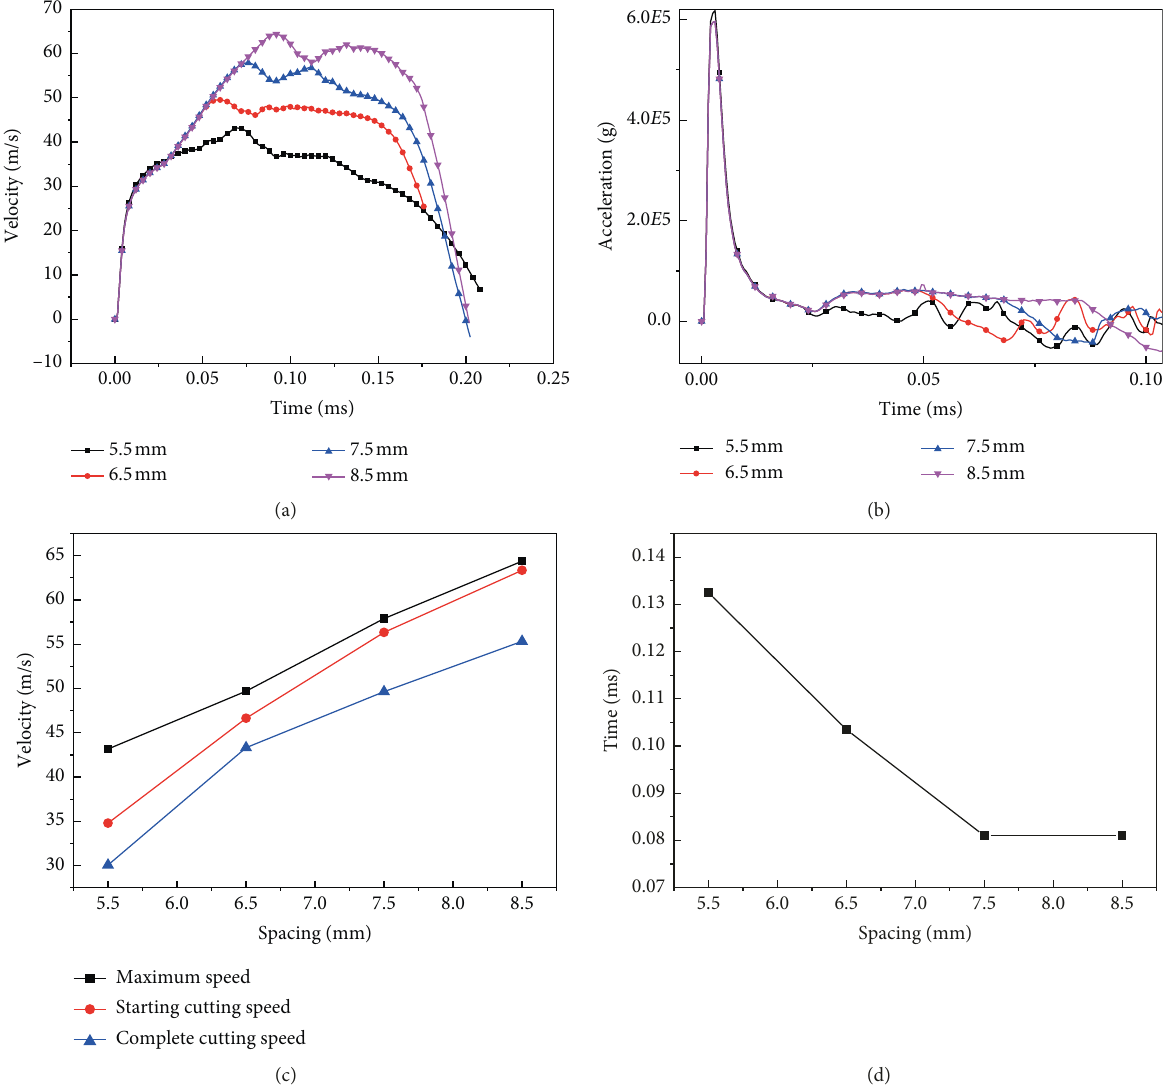
Figure 11: (a) Velocity of the cutter blade for different spacing values. (b) Acceleration of the cutter blade for different spacing values. (c) Relationship between initial speed and completion speed and spacing during cutting. (d) Cutting time of the connecting rod vs. the spacing. Table 7: Numerical simulation results for the maximal cutting diameter of the connecting rod of the pyrotechnic cutter. Spacing Diameter of connecting (mm) rod (mm)